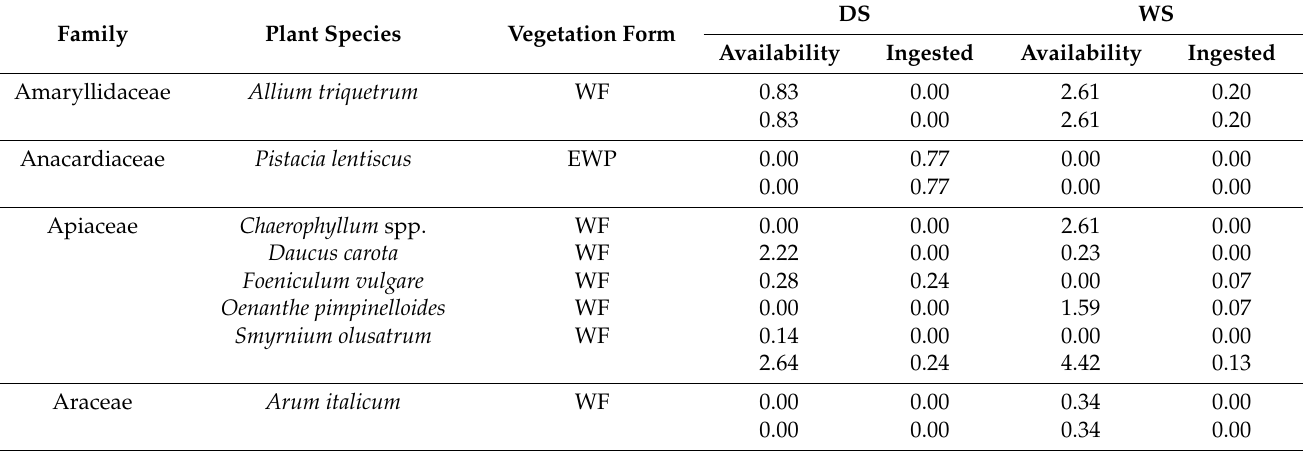
Table A1. Frequencies (%) of Plant species, Families, and Vegetation forms ( 1 ) in dry season (DS) and in wet season (WS), in vegetation (availability) and in diet